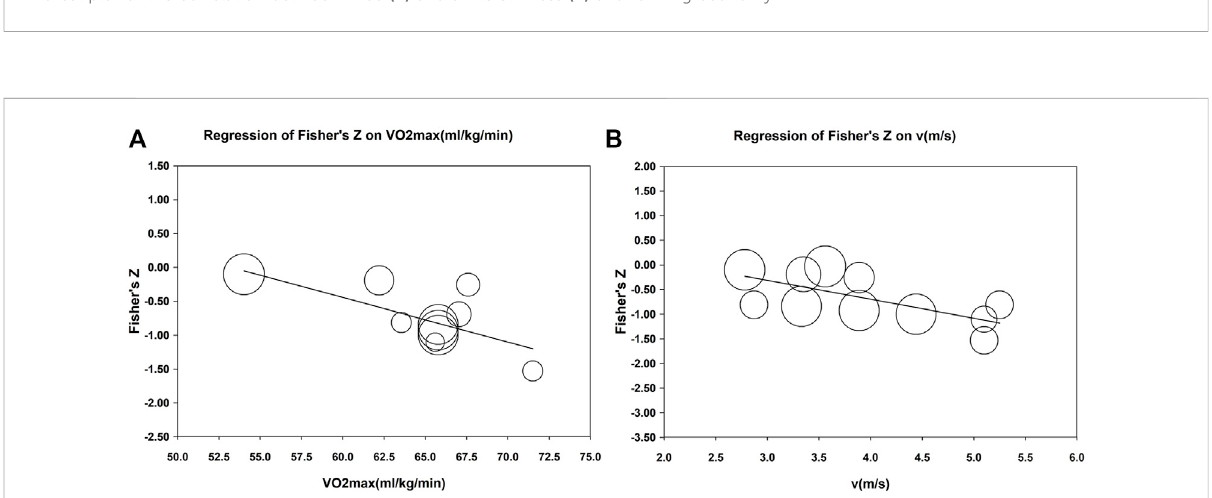
FIGURE 5 Meta-regression of VO 2max (A) and testvelocity (B) with correlation coef fi cients of leg stiffness and RE. The size of each circle is proportional to the study ’ s weight.